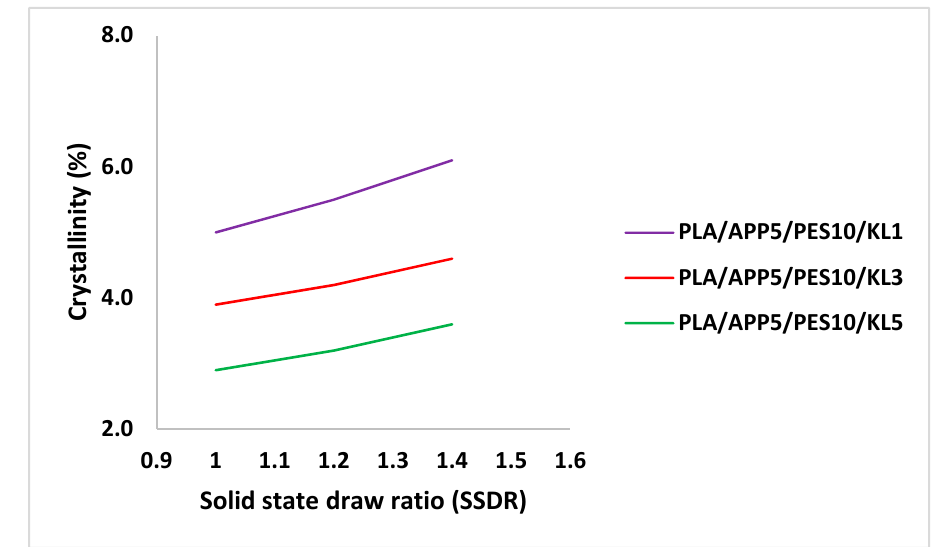
Figure 8. Crystallinity of bicomponent fibers as a function of draw ratio.